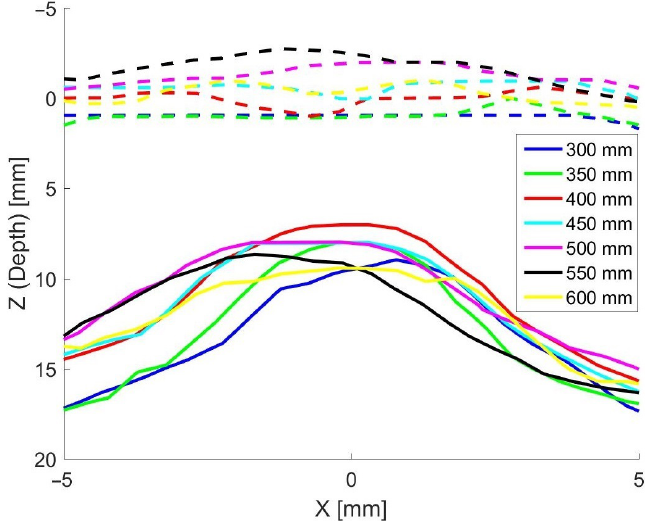
Figure 11. Plots showing cross-sections of scans made by the Kinect Azure of a single grape before (solid lines) and after (dashed lines) the grape had been painted. The different colours represent scans made with the camera being located at distances from the grape ranging from 350 to 600 mm.